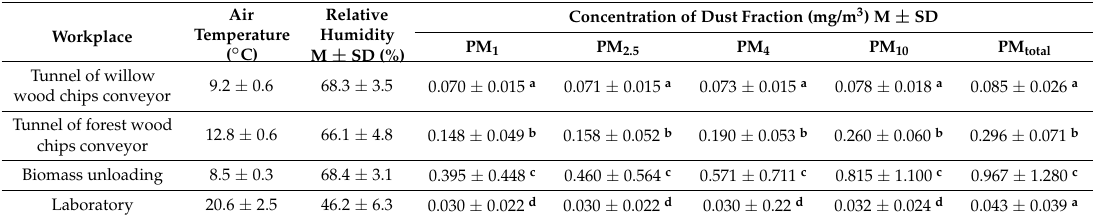
Table 3. Microclimate characteristics and dust concentration at workplaces in the power plant. Air Temperature Workplace Tunnel of willow wood chips conveyor Tunnel of forest wood chips